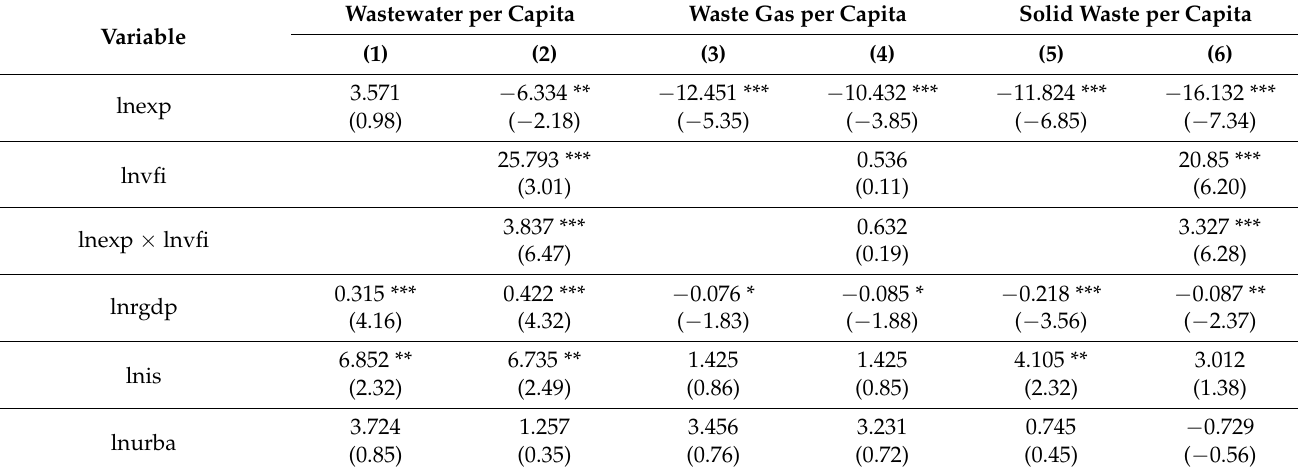
Table 4. Basic regression results of the effects of vertical fiscal imbalance on the pollution reduction effect of the expenditure structure (three types of waste per